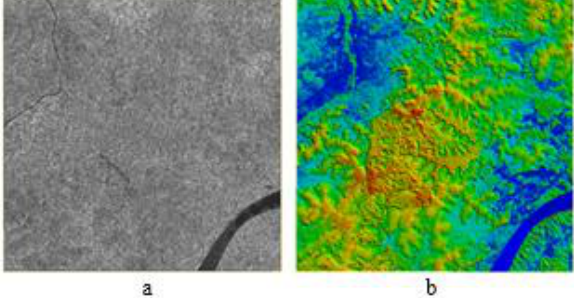
Figure 1. (a) ORRI, (b) DSM (Susetyo et al , 2016)